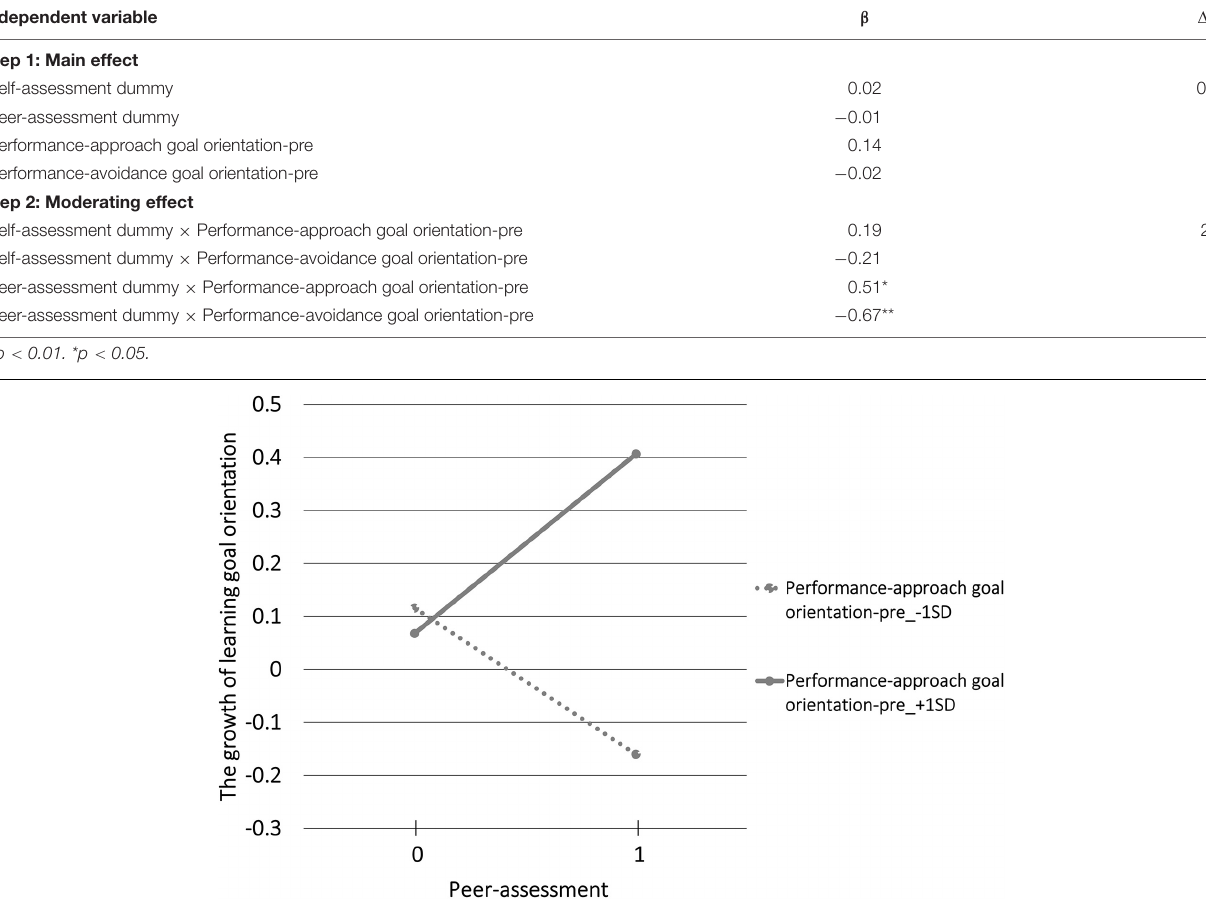
TABLE 3 | Results of hierarchical multiple regression